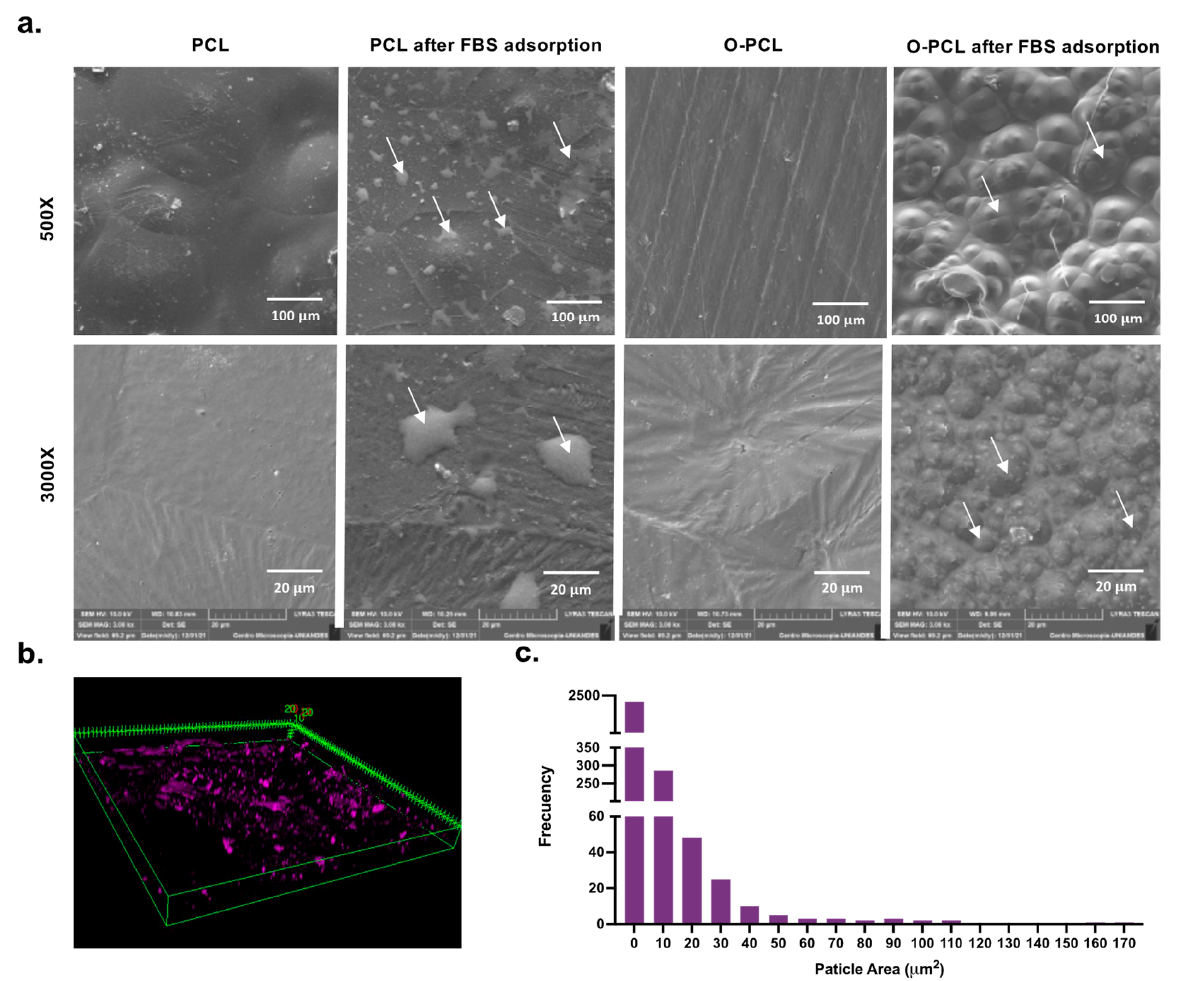
Figure 5. ( a ) SEM surface morphology of PCL and O-PCL before and after 24 h of FBS protein adsorption at 500 × and 3000 × magnifications. Arrows point to protein aggregation clusters. ( b ) Confocal imaging at 20 × magnification of RhB-labeled albumin adsorbed on the multilayer scaffold. Reference dimensions are shown in micrometers ( µ m). ( c ) Histogram for particle size distribution of the adsorbed proteins as calculated using Fiji ® and ImageJ ® .